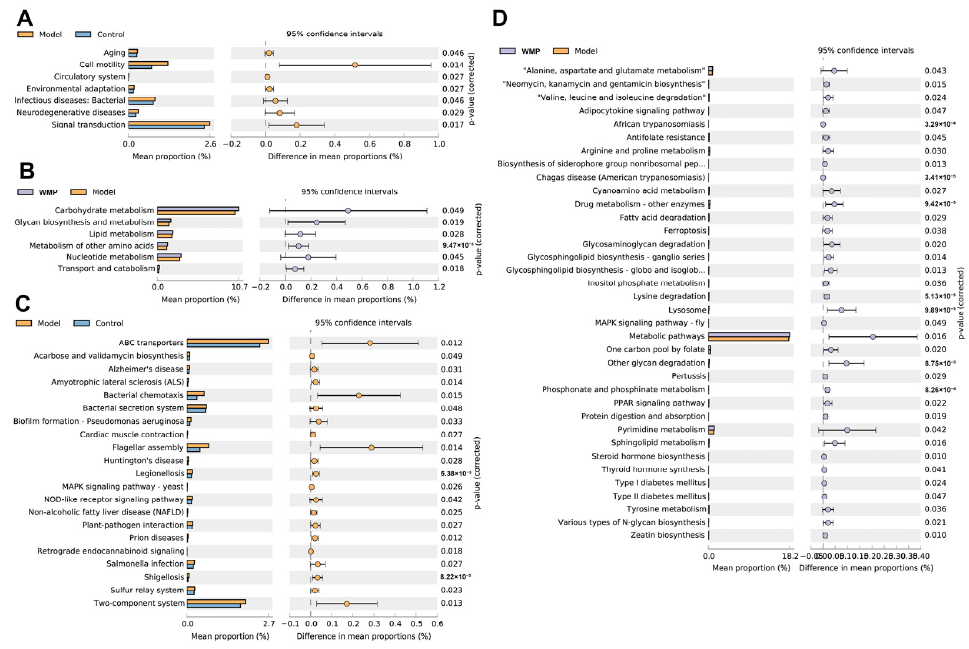
Figure 7. Effects of WMP on the functional profile of the gut microbiota. ( A , B ) the enriched KEGG pathways at level 2, ( C , D ) the enriched KEGG pathways at level 3.